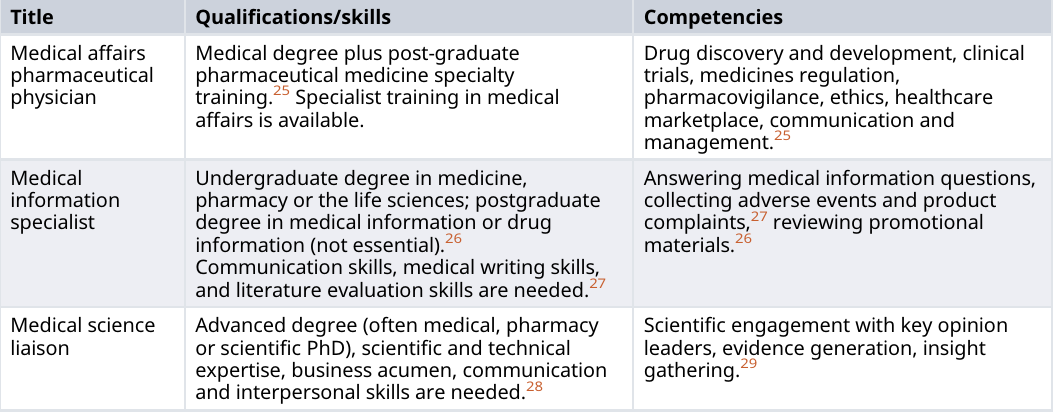
Table 1. Role scope and competencies of physician and non-physician specialists in medical